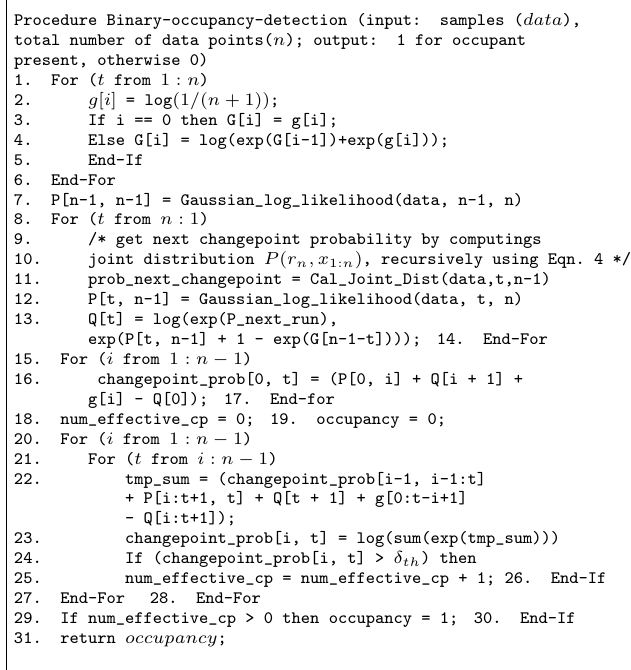
Figure 5: Binary Occupancy Detection